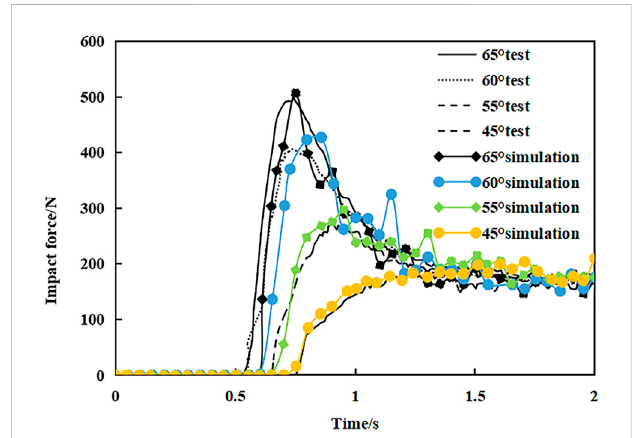
FIGURE 11 Comparison of impact force time history curve between test and numerical simulation.